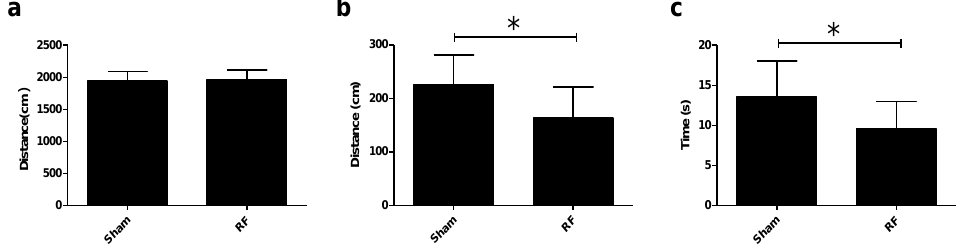
Figure 2. Effects of RF field exposure on anxiety-like behaviors. ( a ) Total distance traveled in OFT (t = 0.385, df = 18, P = 0.705), ( b ) accumulative distance in the center area in OFT (t = 2.5, df = 18, P = 0.022), ( c ) time spent in the central area in OFT (t = 2.548, df = 18, P = 0.020). All data are presented as mean ± SD, * P < 0.05, compared with the sham group.